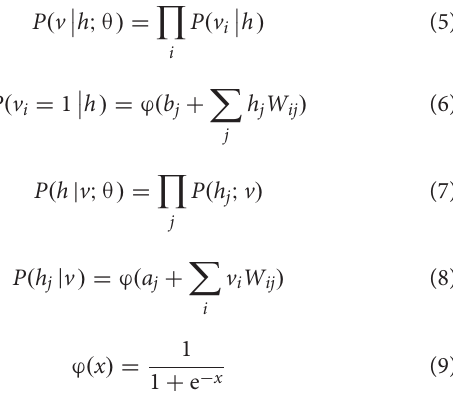
Equation (4) is the marginal distribution function of visible units. The characteristic of this function is that when the energy of the system changes, it gives a high probability to the system with low energy and a low probability to the system with high